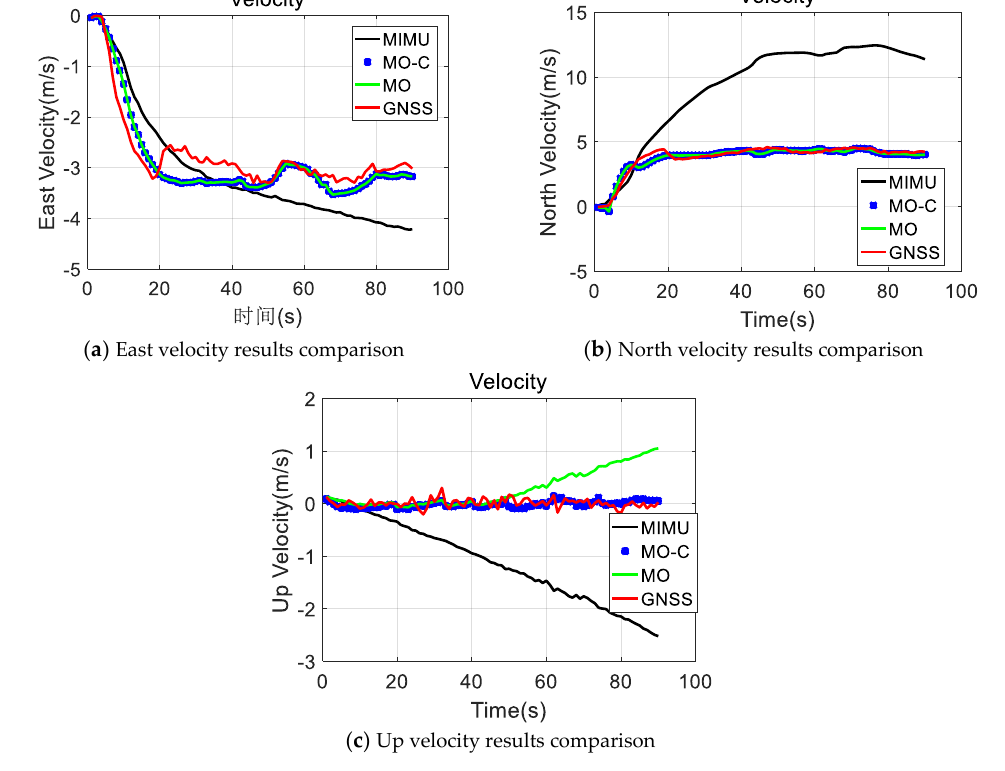
Figure 5. Positioning results comparison.